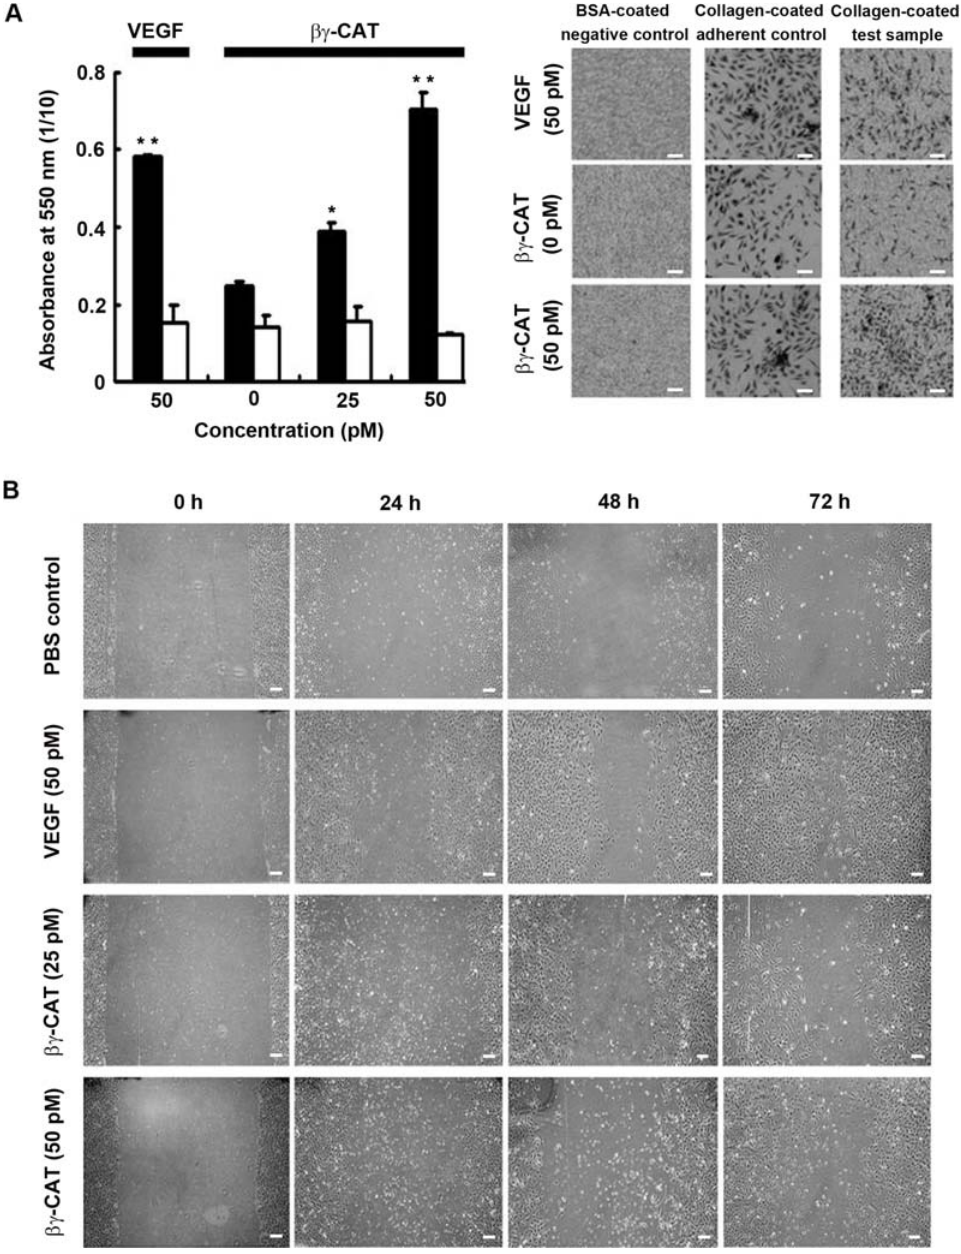
Figure 6. Stimulation of HUVEC migration and wound healing by low concentrations of bc -CAT. (A) Left part, migration of HUVECs stimulated by bc -CAT was tested by a Boyden chamber assay. Black columns and white columns present collagen-coated chambers and BSA-coated chambers, respectively. Data were expressed as means 6 SEM of triplicate measurements (*, p , 0.05; **, p , 0.01, compared with zero bc -CAT). Right part, the recorded photography under the chambers shows obvious increase of cells after treated with bc -CAT. (B) Closure of an artificial wound in HUVEC monolayers stimulated by bc -CAT. The results were the representative of three independent experiments. Scale bars equal to 100 m m in (A) and